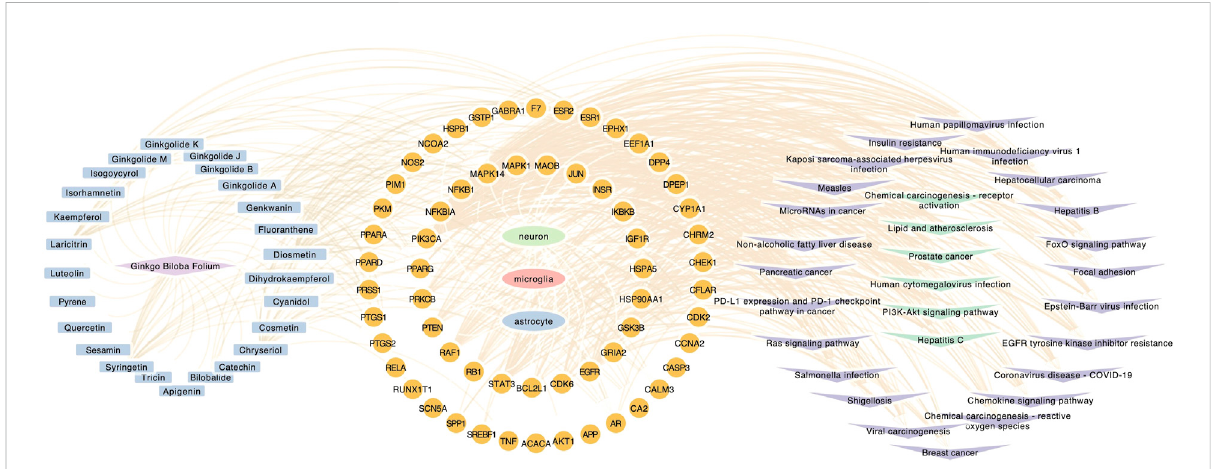
FIGURE 5 Component-target-pathway network. Component-target-pathway were holistic integrated into the network diagram. Blue nodes in the left circle represent potential active components in GBE. Yellow nodes in the middle circle represent PD targets linking to speci fi c cell types. Purple and green nodes on the right circle represent correlating pathways.